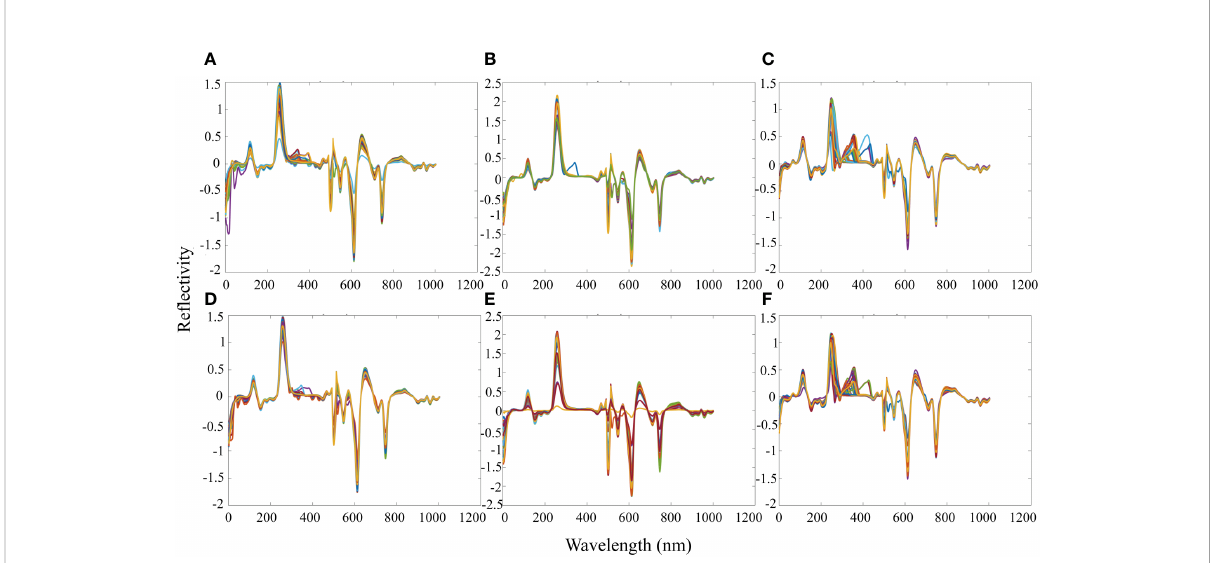
FIGURE 5 Image analysis of spectral data, preprocessed by Savitzky-Golay, under different drought conditions and cotton growth stages. (A) The fl owering stage of cotton under normal conditions; (B) The boll setting stage of cotton under normal conditions; (C) Boll opening stage of cotton under normal conditions; (D) The Flowering stage of cotton under drought stress; (E) The boll setting stage of cotton under drought stress; (F) Boll opening stage of cotton under drought stress.